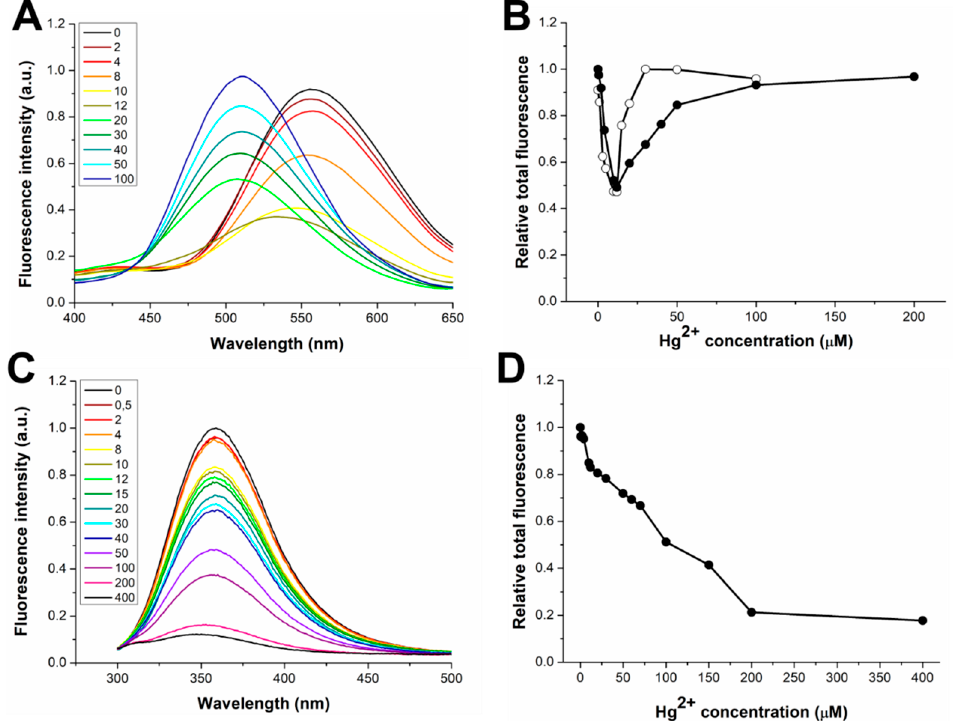
Figure 6. Fluorescence response of dH3w(W6A) and AcH3w as function of Hg(II) concentration. Emission spectra of ( A ) dH3w(W6A) and ( C ) AcH3w. The legends show the concentrations of Hg(II) in µ M units. Normalized area of the fluorescence emission as function of the Hg(II) concentration for ( B ) dH3w(W6A) and ( D ) AcH3w (filled circles). ( B ) The normalized area of the fluorescence emission of dH3w (void circles) is also shown for comparison. Spectra of dH3w(W6A) were registered after excitation at 340 nm (the absorption maximum of the dansyl group). Spectra of AcH3w were registered after excitation at 295 nm.